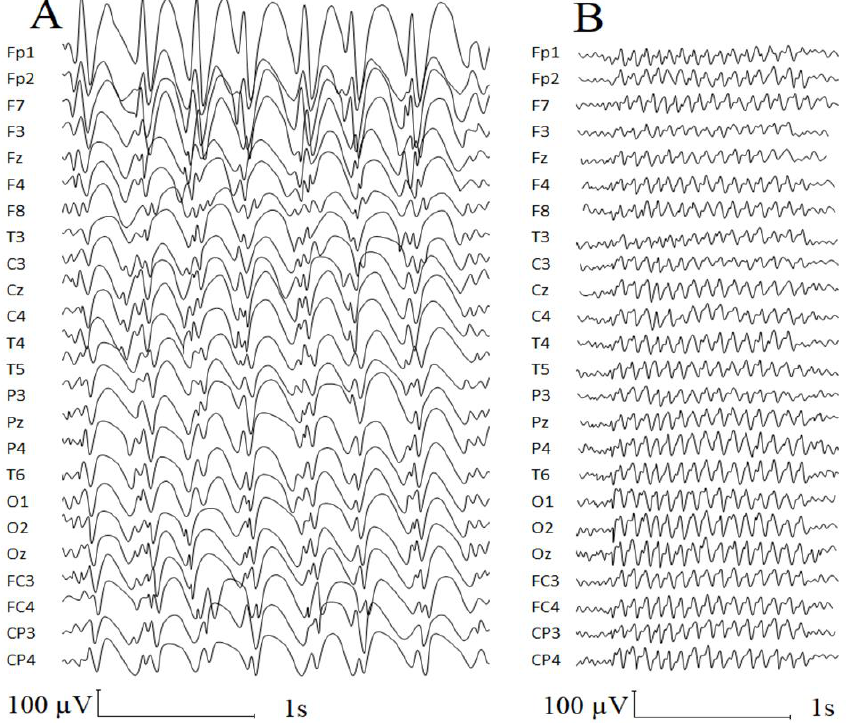
Figure 1. The types of atypical paroxysmal activity found in the current patient: ( A ) atypical absences; ( B ) saw-wave patterns (13.3 Hz). We used base-monopolar montage. A1 and A2 reference electrodes were located on the earlobes.